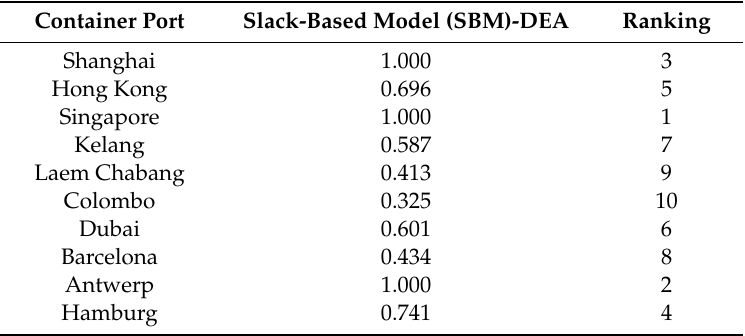
Table 6. Environmental e ffi ciencies of the 10 container ports along the MSR. Container Port Slack-Based Model (SBM)-DEA Ranking Shanghai